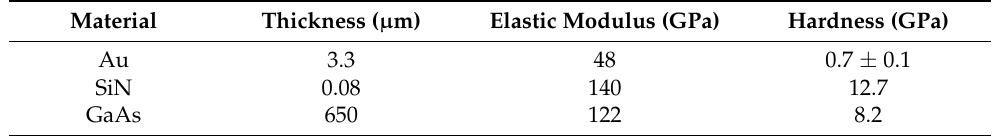
Figure 1. ( a ) A photograph of the Au patterned SiN/GaAs sample; SEM micrographs of ( b ) top and ( c ) cross-sectional surfaces of the Au/SiN/GaAs multilayer sample. Table 1. Thickness and mechanical properties of GaAs, SiN, and Au.